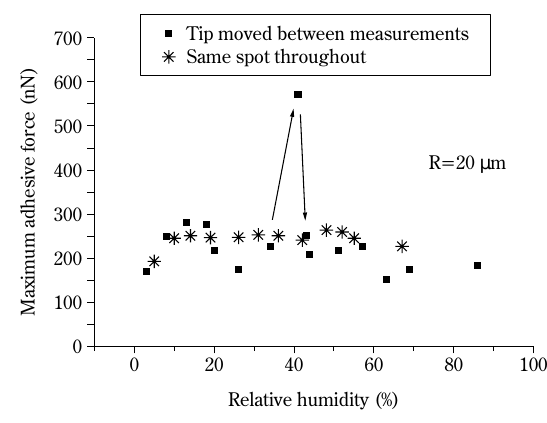
Anomalous adhesion between a glass microsphere and a flat glass surface, both of which were rendered hydropho- bic. Reproduced from Jones et al .